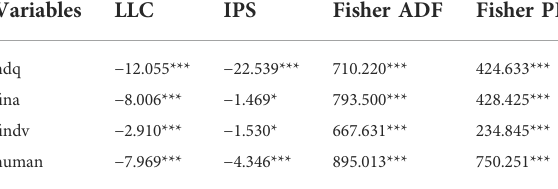
TABLE 4 Unit root test